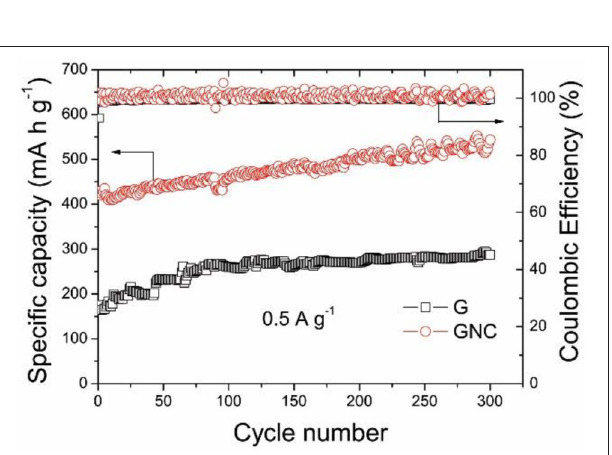
FIGURE 5 | Cycle performances of the graphene nanoplatelets and GNC at 0.5A g − 1 .